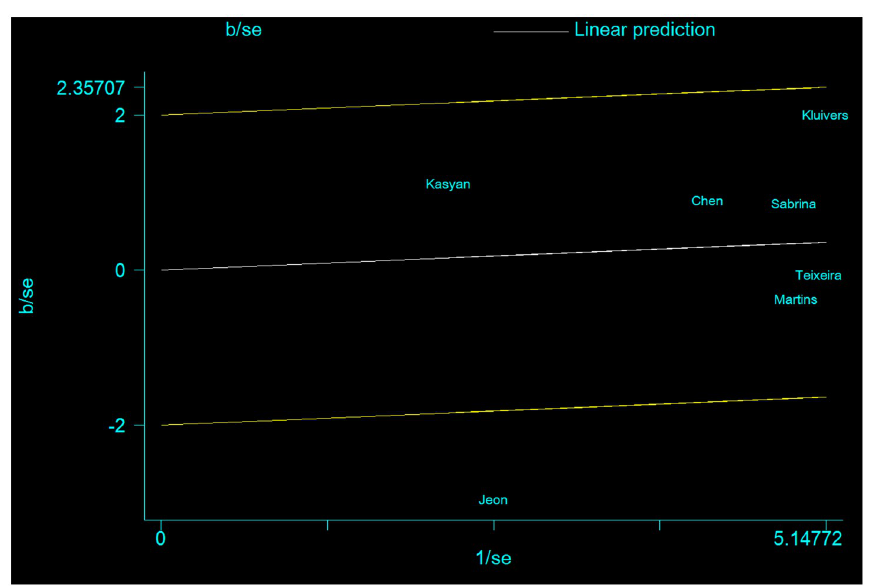
Fig 4. Galbraith plot of COL3A1 rs1800255 polymorphism and POP risk by allele contrast: A vs. G.